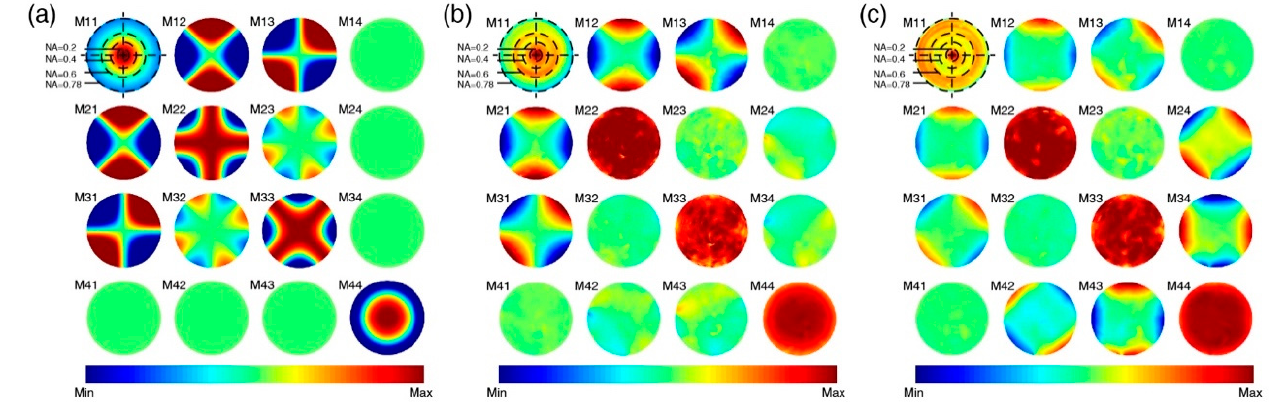
Figure 5. Mueller matrices of the spectrum of plane waves from the exit pupil for ( a ) uncoated spherical lens model (theoretical calculation), ( b ) uncoated aspherical lens system, and ( c ) coated aspherical lens system. The areas corresponding to different NA values are labeled with black dotted lines in the M11 element. The M11 elements were normalized to [0, 1], while all the other elements were normalized with the M11 to [–1, 1]. The color bars in ( a – c ) are [0, 1] for the M11 element; [0.8, 1] for the M22, M33, and M44 elements; and [ − 0.25, 0.25] for other nondiagonal